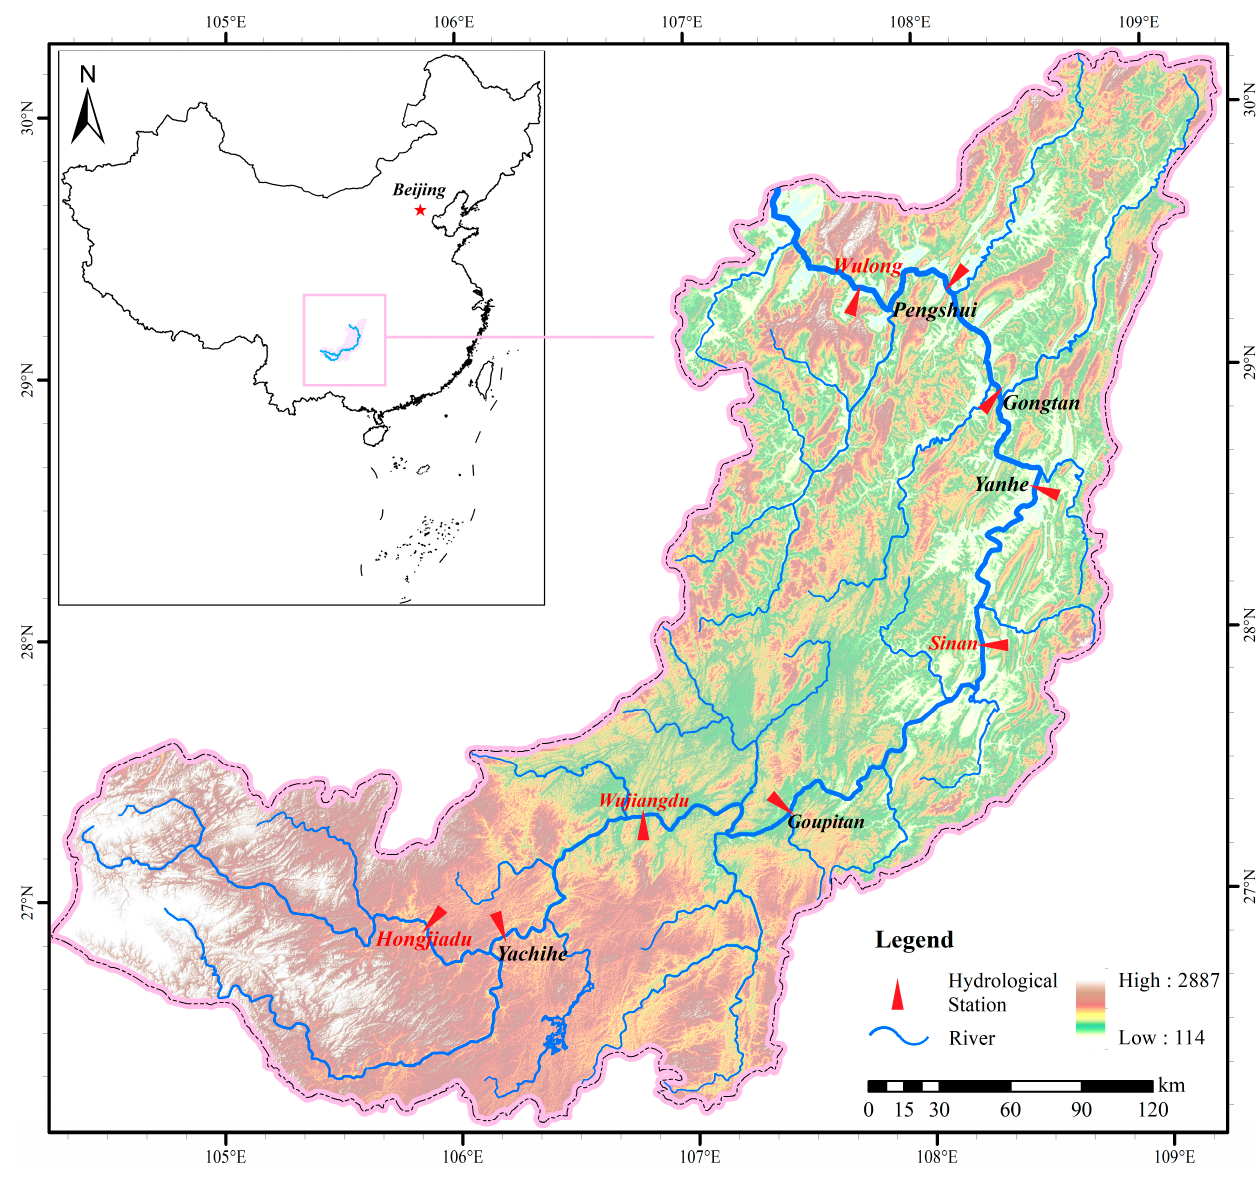
Figure 1. Map of the Wujiang River Basin.